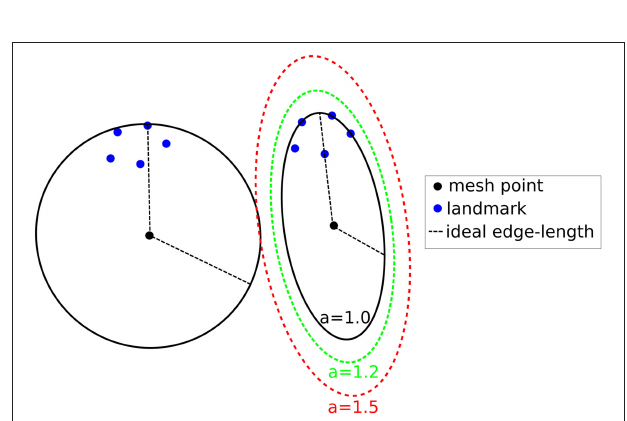
FIGURE 5 | Visualization of the metric construction for mesh adaptation. Left isotropic metric that set the spacing equal to the distance of the 5th closest registration point. Right anisotropic metric based on the five registration points for different values of the inflation parameter a .